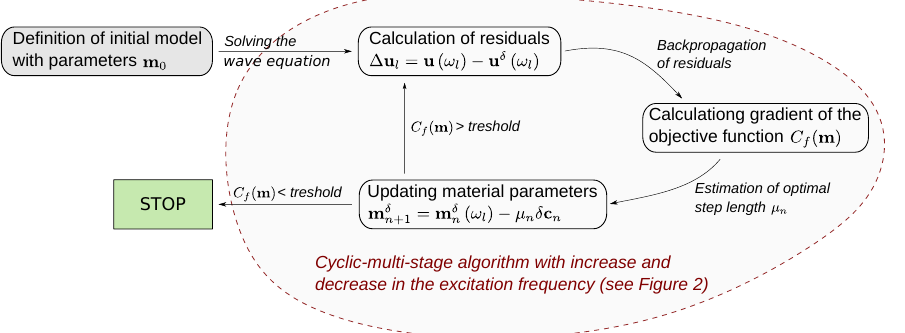
Figure 1. Flow chart of full-waveform inversion procedure.